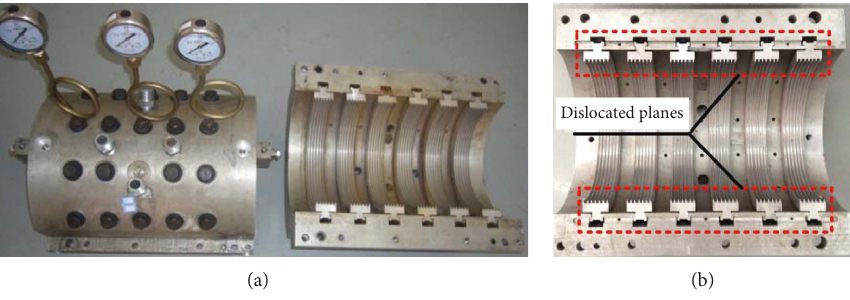
Figure 4: Cylinder and installation of NDS on seal test rig.